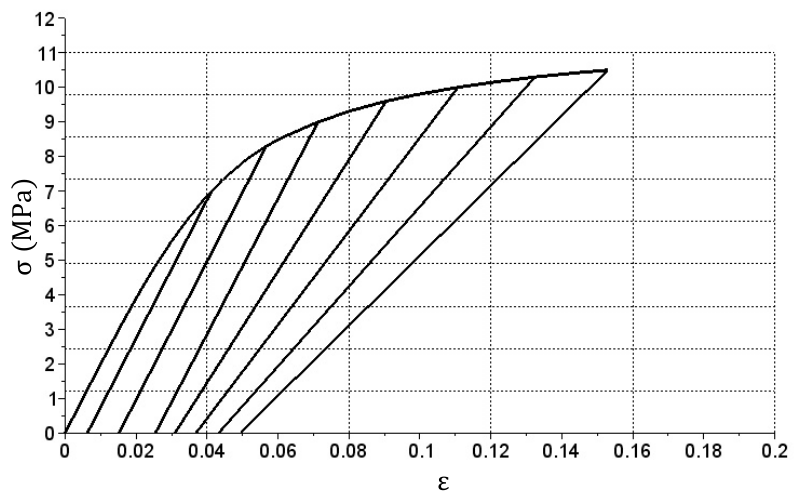
Figure 12. σ ( ε ) relation graph produced during the simulation of cyclic tension and relief of the bar with changing E n matrix values.